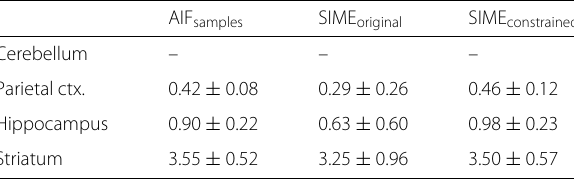
Table 1 Average non-displaceable binding potential (BP ND ) calculated across 10 scans with the standard deviation using input function derived from AIF samples , SIME original and SIME constrained AIF samples SIME original SIME constrained Cerebellum – Parietal ctx. 0.42 ± 0.08 0.29 ± 0.26 0.46 ± 0.12 Hippocampus 0.90 ± 0.22 0.63 ± 0.60 0.98 ± 0.23 Striatum 3.55 ± 0.52 3.25 ± 0.96 3.50 ±